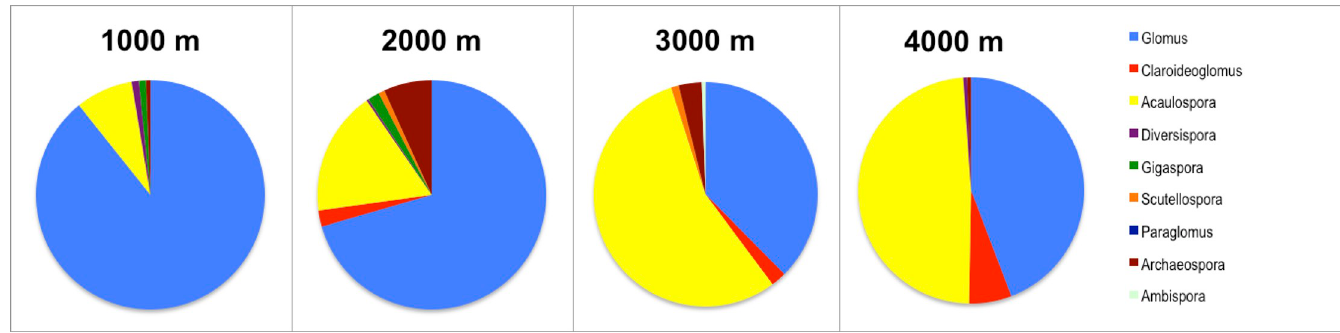
Fig 4. Relative abundance of Glomeromycotina genera for each elevation level in number of sequences. Members of Glomus (in light blue) were the dominant mycorrhizal fungi in evergreen premontane forest ( � 1000 masl) and the evergreen lower montane forest ( � 2000 masl). In the upper montane forest ( � 3000 masl) and pa´ramo ( � 4000 masl) members of the genus Acaulospora (in yellow) were most abundant.